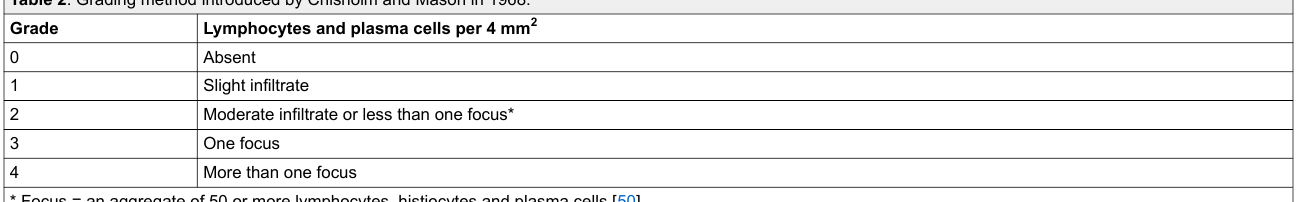
Table 2 : Grading method introduced by Chisholm and Mason in 1968.